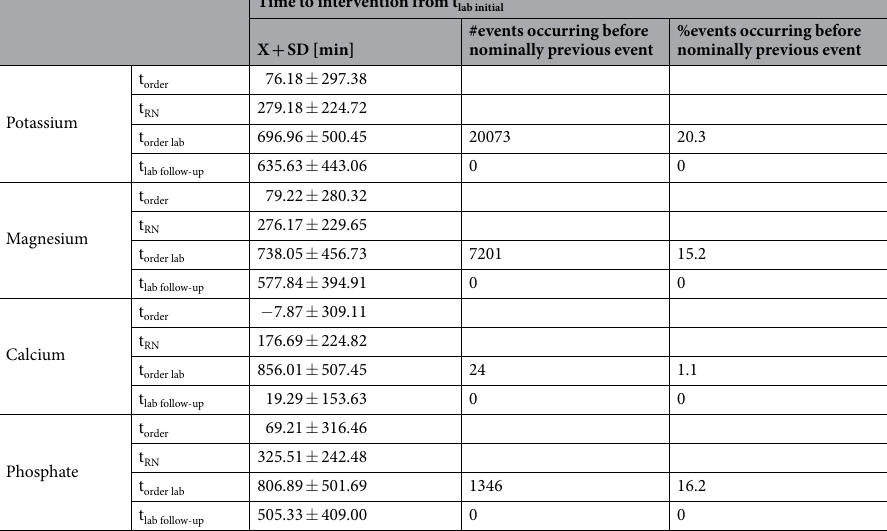
Table 3. Average time to intervention from initial lab. t order the interval between prior lab result and placing the order. t RN interval between ordering and executing the order. t order lab the interval between completion of the replacement and ordering follow-up lab. t lab follow-up the interval between ordering the lab and follow up results showing